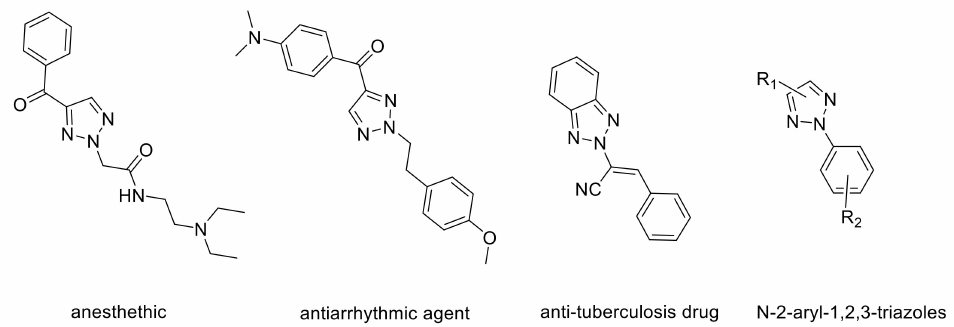
Figure 1. 2-Substituted 1,2,3-triazoles in medicine and generalized structure of UV / blue-light-emitting N-2-aryl-1,2,3-triazoles.